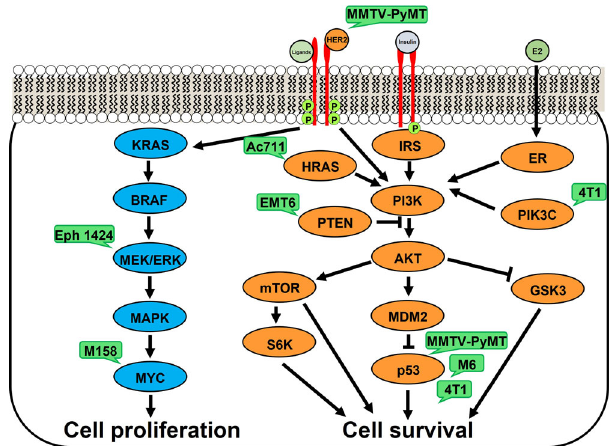
Fig. 7 Driver mutations tested in this study. Green bubbles show models utilized